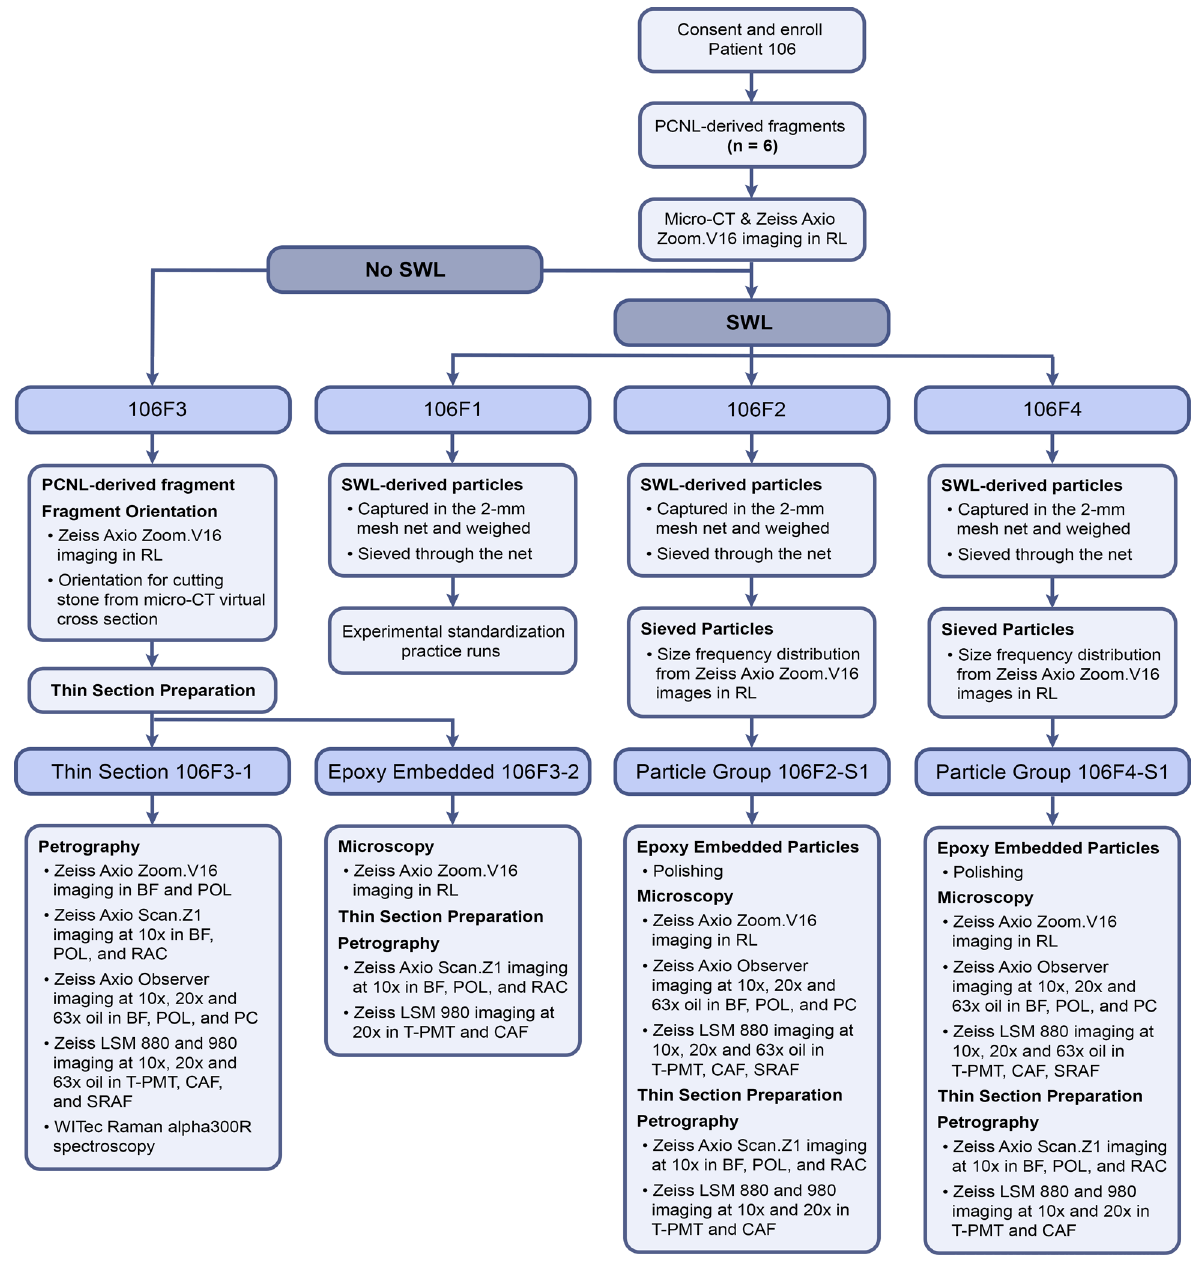
tomography, RL reflected light, BF brightfield, POL polarization, RAC ring aperture contrast, PC phase contrast, T-PMT transmitted light photomultiplier tube, CAF confocal autofluorescence, SRAF